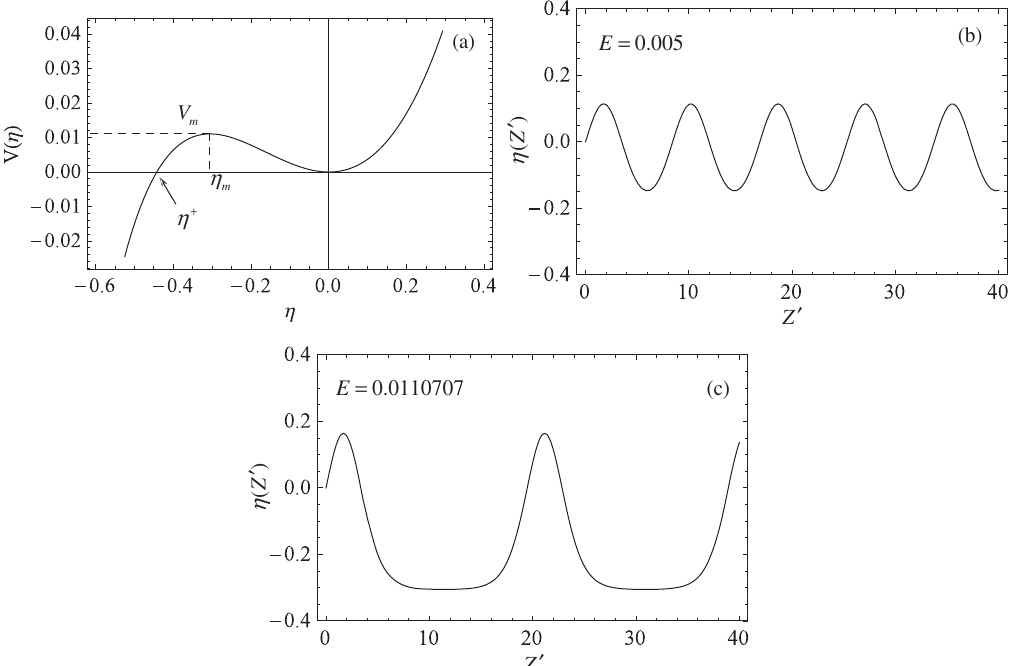
0 . 8 , η þ ¼ − 0 . 442 , η − 0 . 306 and V ð η 0 . 0111 , plots are shown for (a) V ð η Þ versus η ; (b) η ð Z 0 Þ FIG. 3. For M 2 ¼ 0 . 36 , ϵ T ¼ m ¼ m Þ ¼ versus Z 0 for η 0 ð 0 Þ ¼ 0 . 1 and E ¼ ð 1 = 2 Þ½ η 0 ð 0 Þ(cid:4) 2 ¼ 0 . 005 ; and (c) η ð Z 0 Þ versus Z 0 for η 0 ð 0 Þ ¼ 0 . 1488 and E ¼ ð 1 = 2 Þ½ η 0 ð 0 Þ(cid:4) 2 ¼ 0 . 0110707